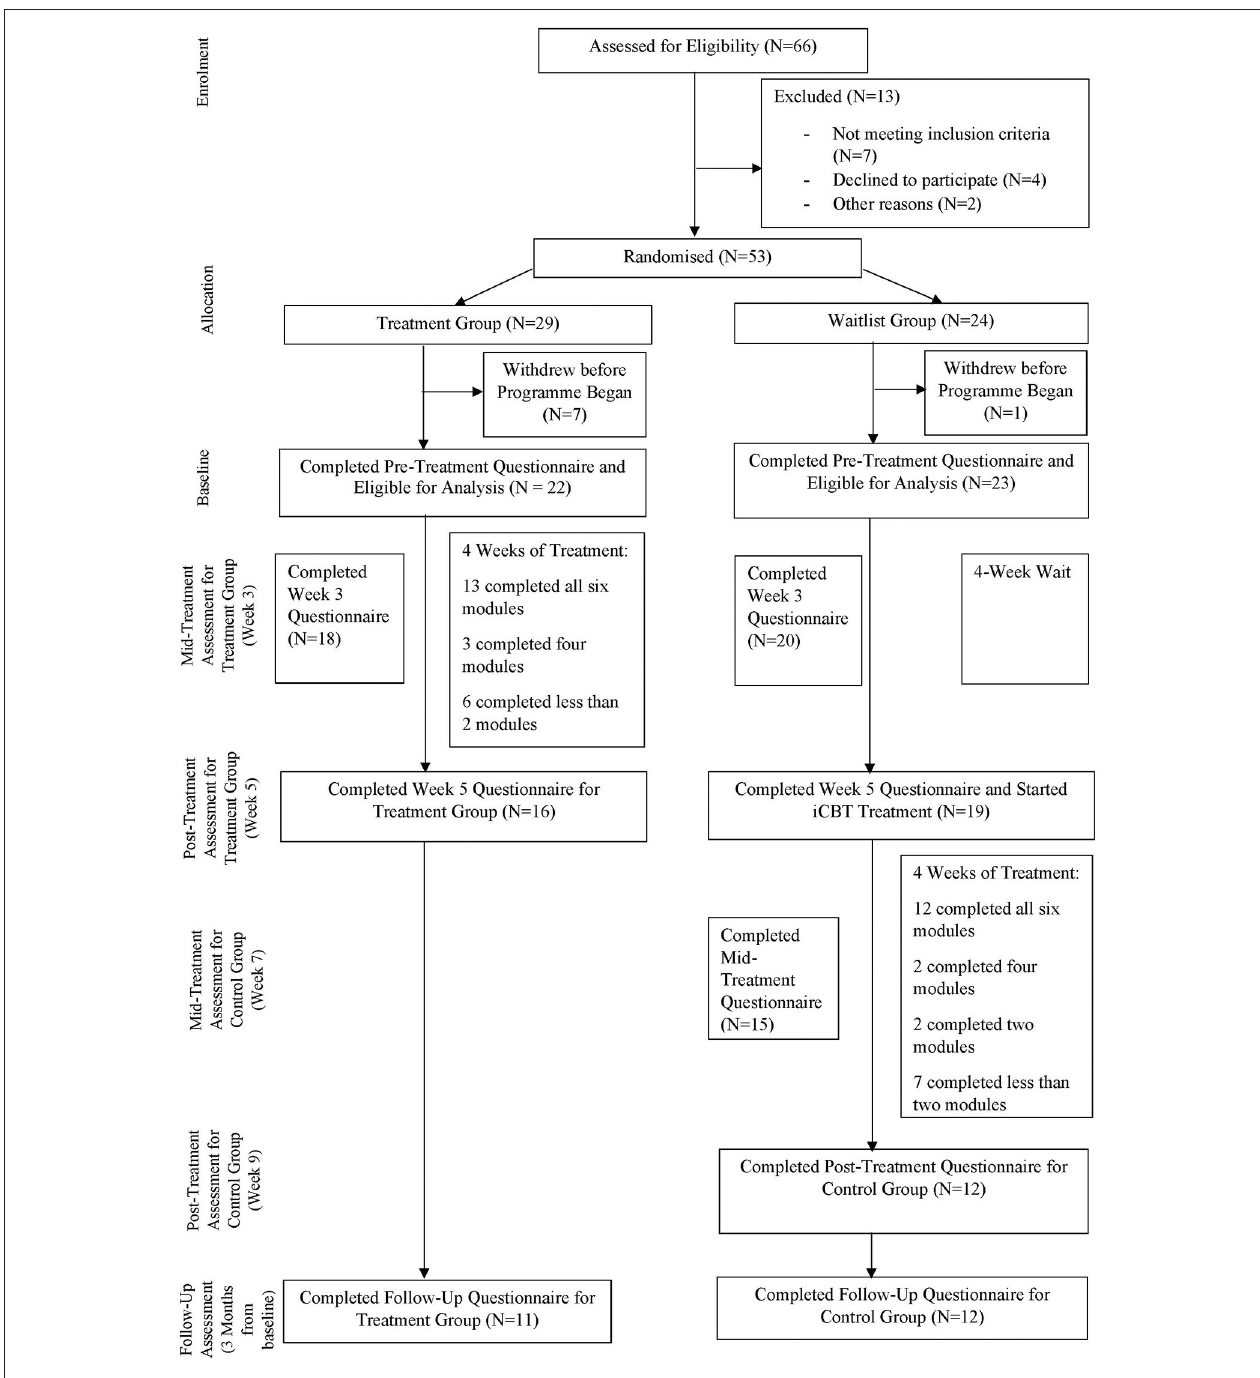
FIGURE 1 | Participants flow